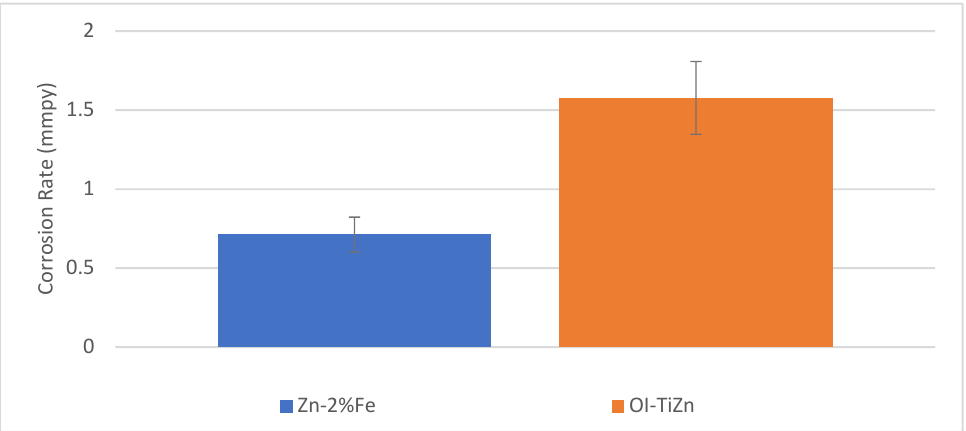
Figure 8. Corrosion rate measurements obtained after immersion tests of Zn–2%Fe alloy and OI–TiZn system in PBS solution at 37 °C for 14 days.